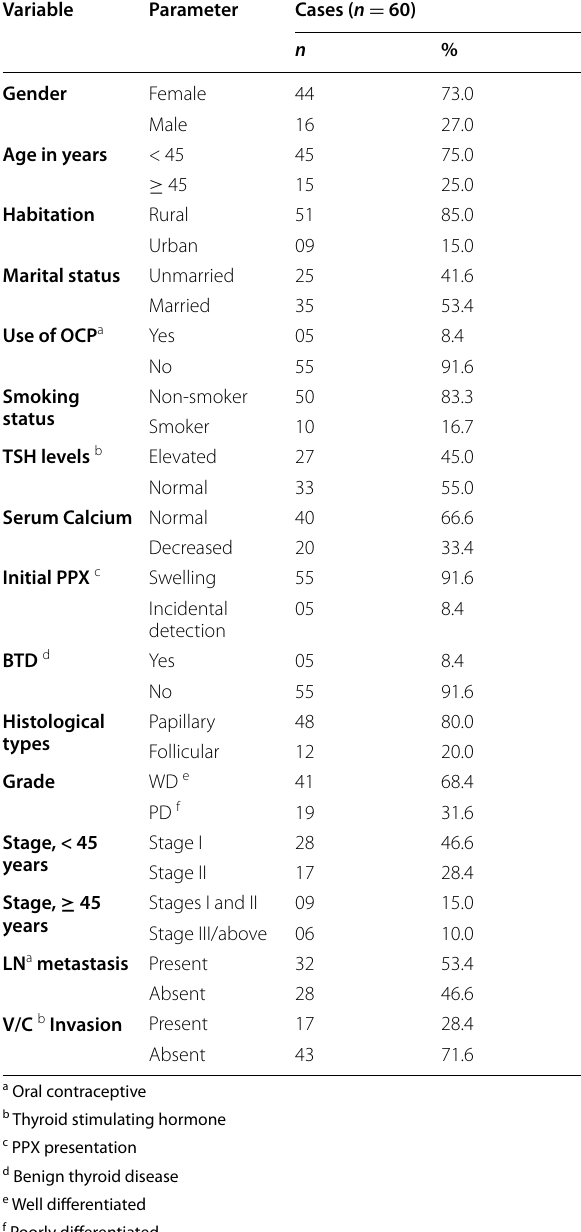
Table 2 Demographic and clinico-pathological variables in our study